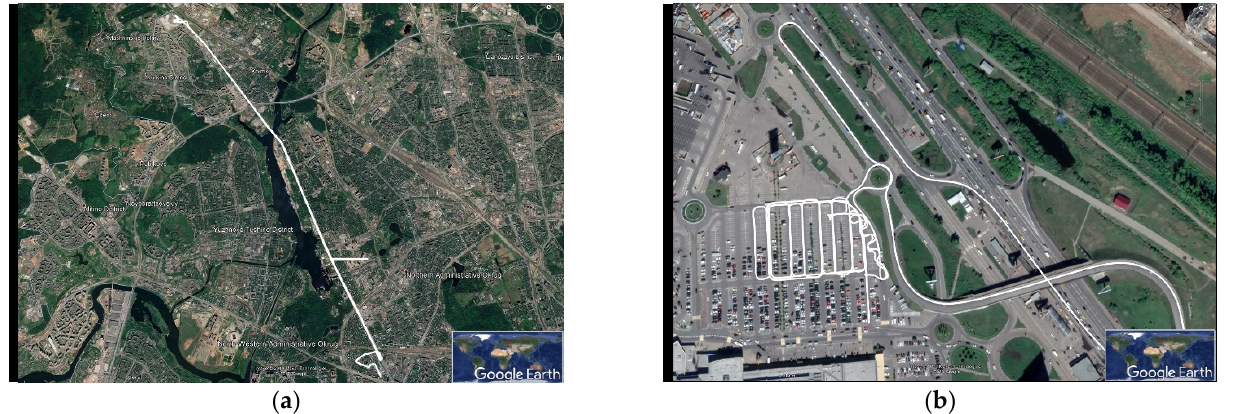
Figure 5. Car test track: ( a ) whole track; and ( b ) track leg with active maneuvering.